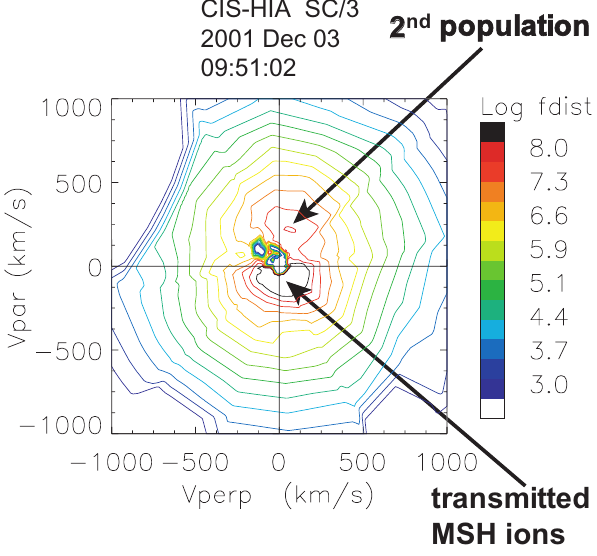
Fig. 5. SC/3 ion distribution function on the (V ⊥ ,V k ) plane at 09:51:02 UT when the spacecraft is in the current sheet. A sec- ond population parallel to the magnetic field is present besides the transmitted magnetosheath ions.